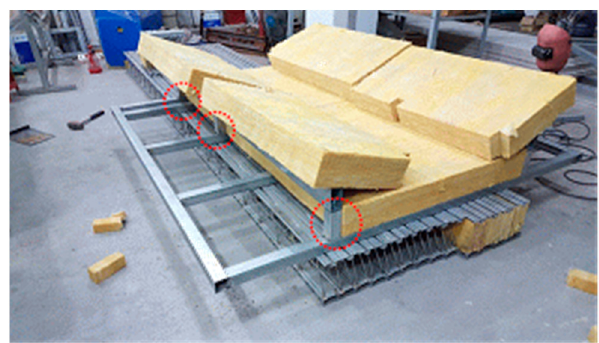
Figure 7. Test specimen for the dry exterior insulation system using steel pipes.